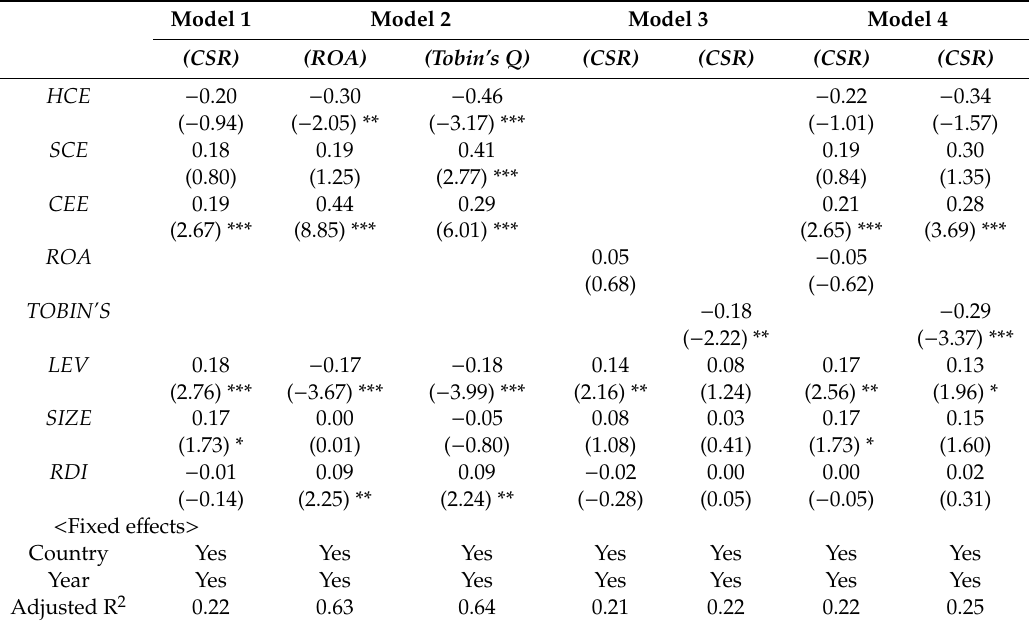
Table 2. Mediating e ff ect of financial performance (IC and